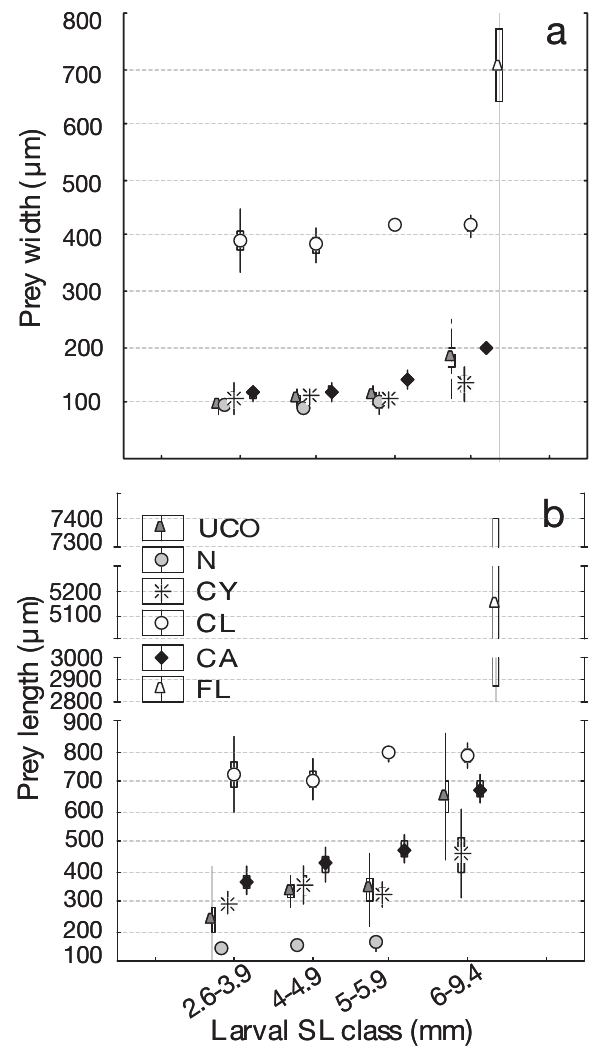
F IG . 3. – Mean prey width (a) and length (b) of the main prey cate- gories in relation to SL of T. alalunga . Bars are ± 95% confidence intervals, and inner rectangles are ± 1 Standard